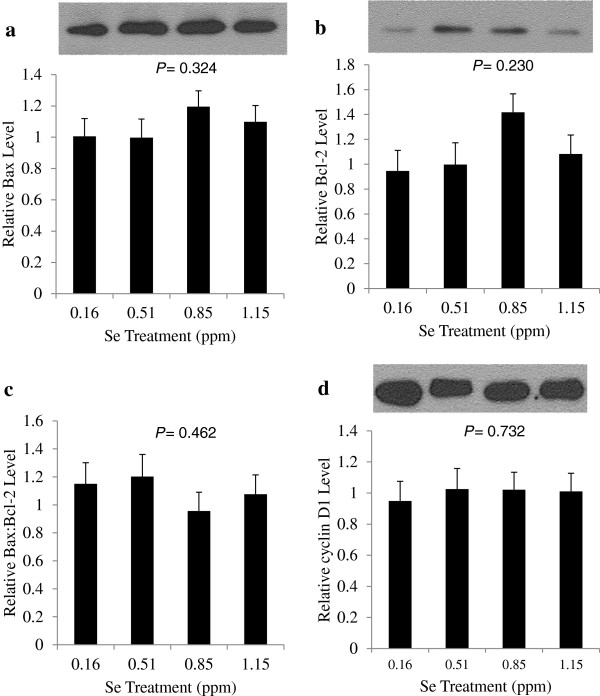
Effects of selenium treatments on Bax, Bcl-2 and cyclin D1 protein levels. After 70 d of Se-casein treatment, tumors were excised from mice and subjected to western blot analysis for a) Bax, b) Bcl-2, c) Bax:Bcl-2 ratio and d) cyclin D1. Expression levels were normalized to β-tubulin. Values in bar graphs are means ± SE for each treatment group (n = 11, 10, 14 and 13, respectively). P-values represent linear effects of dietary Se level.